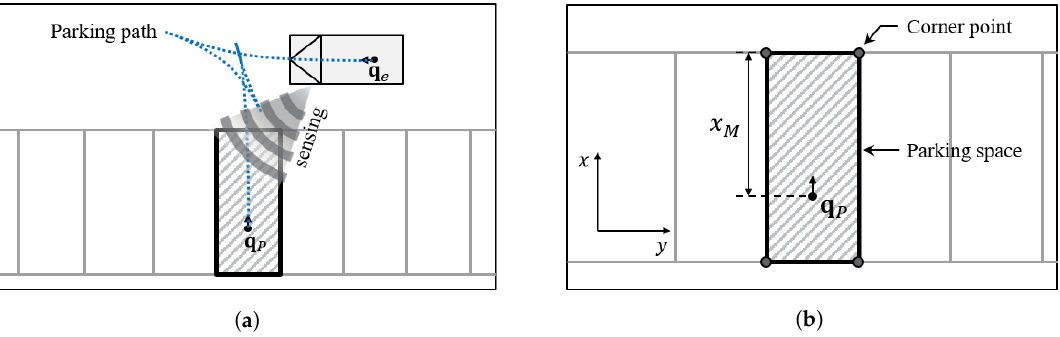
Figure 1. The overall process of parking path planning ( a ), and the definition of a parking space and corner points ( b ).